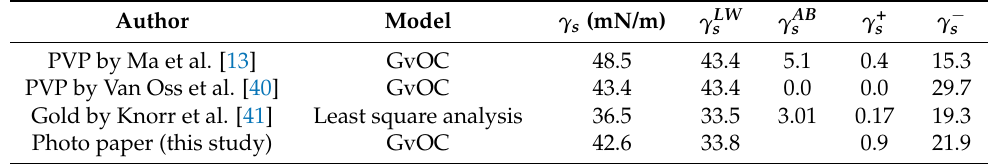
Table 2. SFE polyvinylpyrrolidone (PVP): surface free energy of photo paper (determined experi- mentally), dental gold type III, and polyvinylpyrrolidone as reported in the